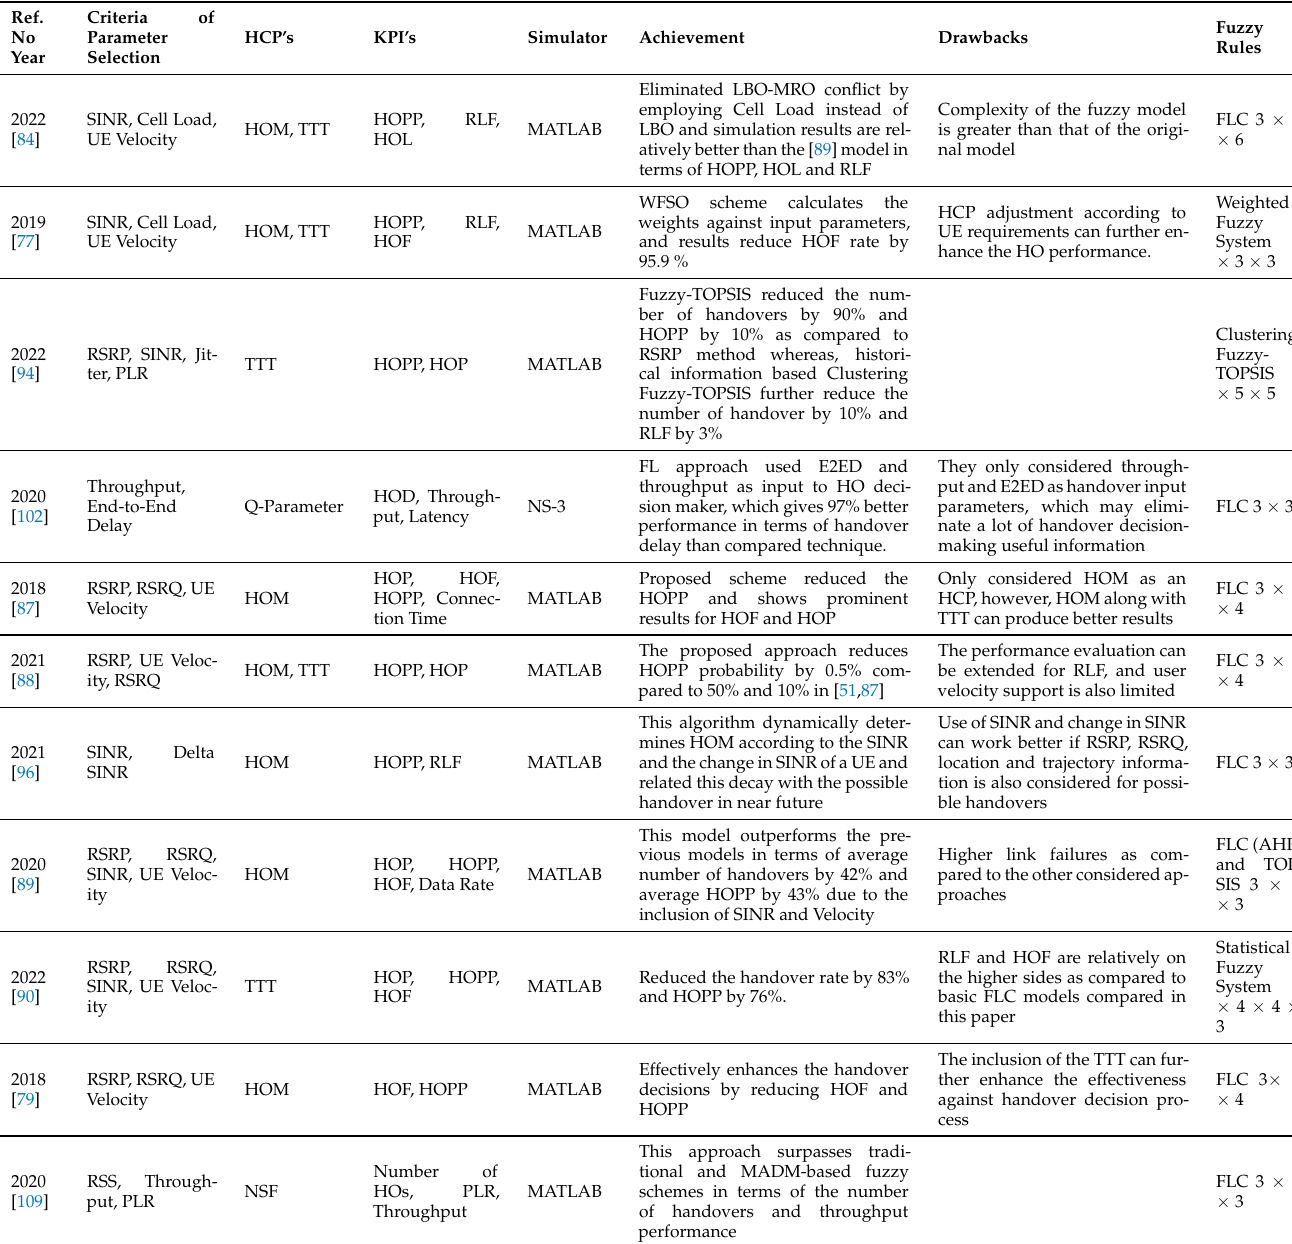
Table 7. Summary of FLC-based Handover Decision